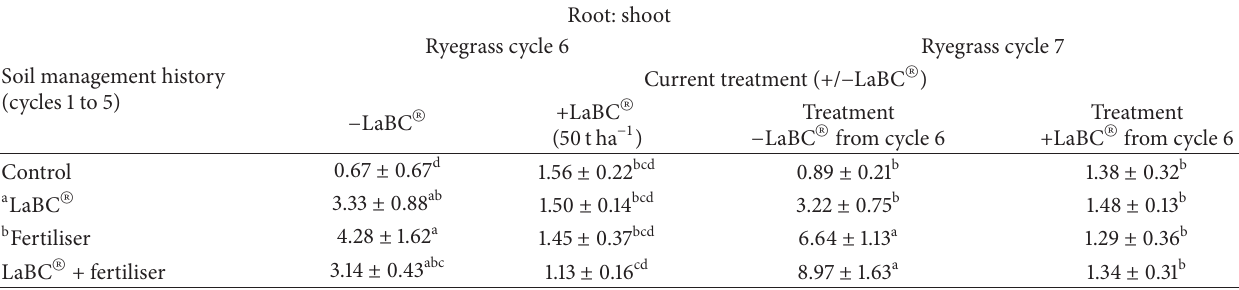
Table5:Root : shootinryegrasscycles6and7withreappliedLaBC Ⓡ (+/ − )asinfluencedbyresidualeffectsofsoilamendmentsfromprevious management history.